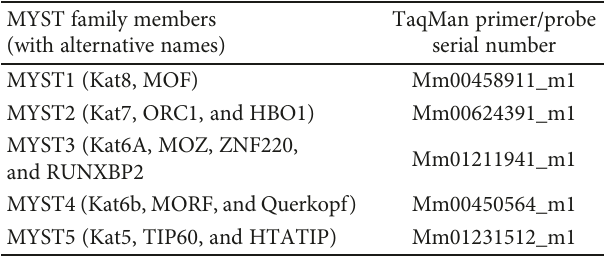
Figure 1: Region of the Kat6b 3 ′ UTR sequence containing the putative miR-487b conserved binding site, indicated in bold. The complete 3 ′ UTR (1995 bases) was inserted into the pLightswitch 3 ′ UTR luciferase reporter plasmid, using the NHE1/XHO1 restriction sites, generating the pKat6bLuc-3 ′ UTR plasmid (SwitchGear Genomics, Carlsbad, CA, Product ID S810637). Five bases (TACGA) were deleted from the miR-487b binding site to generate the mutant clone (pKat6bLuc Δ 3 ′